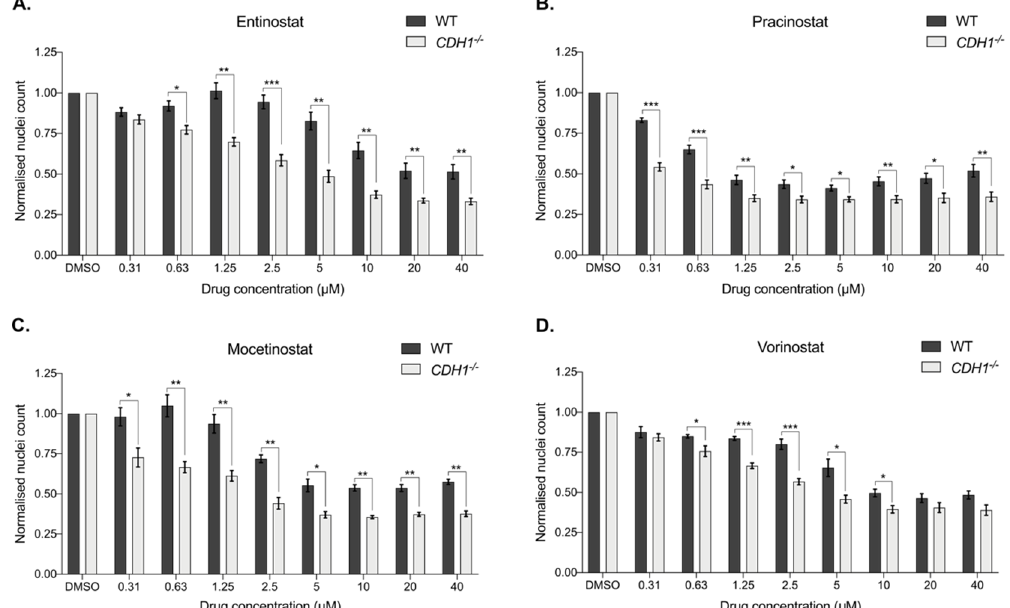
Figure 2. Pan-HDAC inhibitors have a synthetic lethal effect in gastric cancer cells lacking E-cadherin. A drugging experiment was performed on NCI-N87-WT and NCI-N87- CDH1 − / − cells, and nuclei count was measured after 48 h. ( A ) Entinostat induced a synthetic lethal effect from 0.63 µ M, with a maximum of 36% differences between both groups at 2.5 µ M. ( B ) Effect of pracinostat was significant from 0.31 µ M, with a maximum difference of 29%. ( C ) Mocetinostat was significant from 0.31 µ M, with a maximum difference of 38%. ( D ) Vorinostat induced a synthetic lethal effect from 0.63 to 10 µ M, with a maximum effect at 2.5 µ M, with 23% differences between the two groups; n = 3–5 per compound. All the IC50 are summarized in Table S5. Statistically significant results are labeled